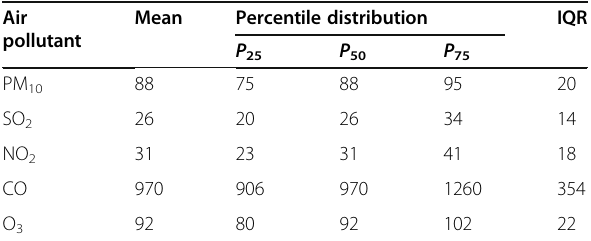
Table 2 Distribution of ambient air pollution